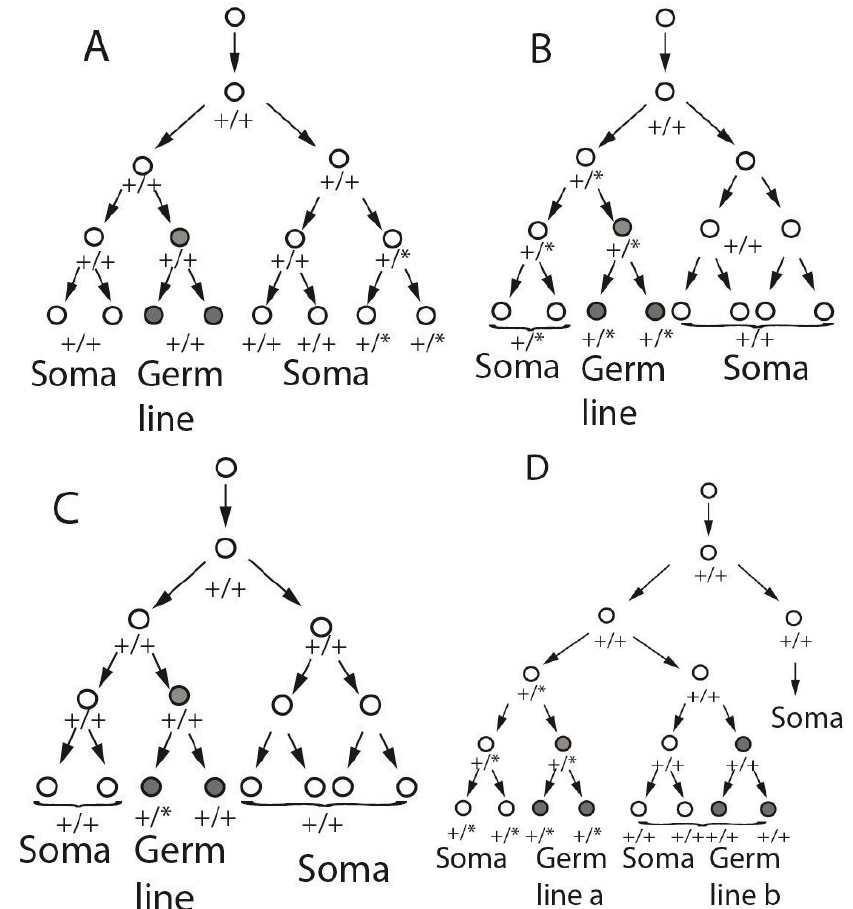
Figure 1. Potential cell lineages of somatic and germ line mosaicism based on alternative specification scenarios. In each panel, the one cell zygote is shown at the top, and following a small number of divisions. At some point, a wild type (+/+) cell gives rise to a mutant cell (+/*), which divides to produce a set of descendants that include all or part of the germ line and/or part of the soma. Panels ( A ), ( B ), and ( C ) assume that a single post-zygotic cell (FGC 1 ) gives rise to the entire germ line. Panel ( D ) assumes two or more post-zygotic cells, of different post-fertilization ancestry, contribute to different portions of the germ line (Germ line a, Germ line b). In each panel, cells contributing to the germ line are shaded in grey. De novo mutations are indicated as asterisks so that cells carrying the mutation are heterozygous +/*. Panel ( D ) shows the lineage outcome in the event of mutation in a cell that gives rise to both germ-line and somatic descendants, in the case of multiple ( i.e. , non-clonal) germ line precursors. These trees are not meant to reflect specific actual cell lineages or the relative size of germ line versus somatic cell